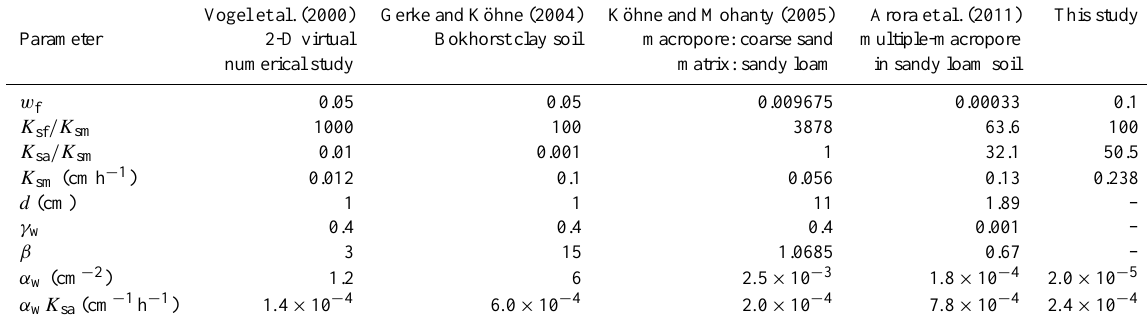
Table 2. Parameters setting of water exchange coefficients in different literature.